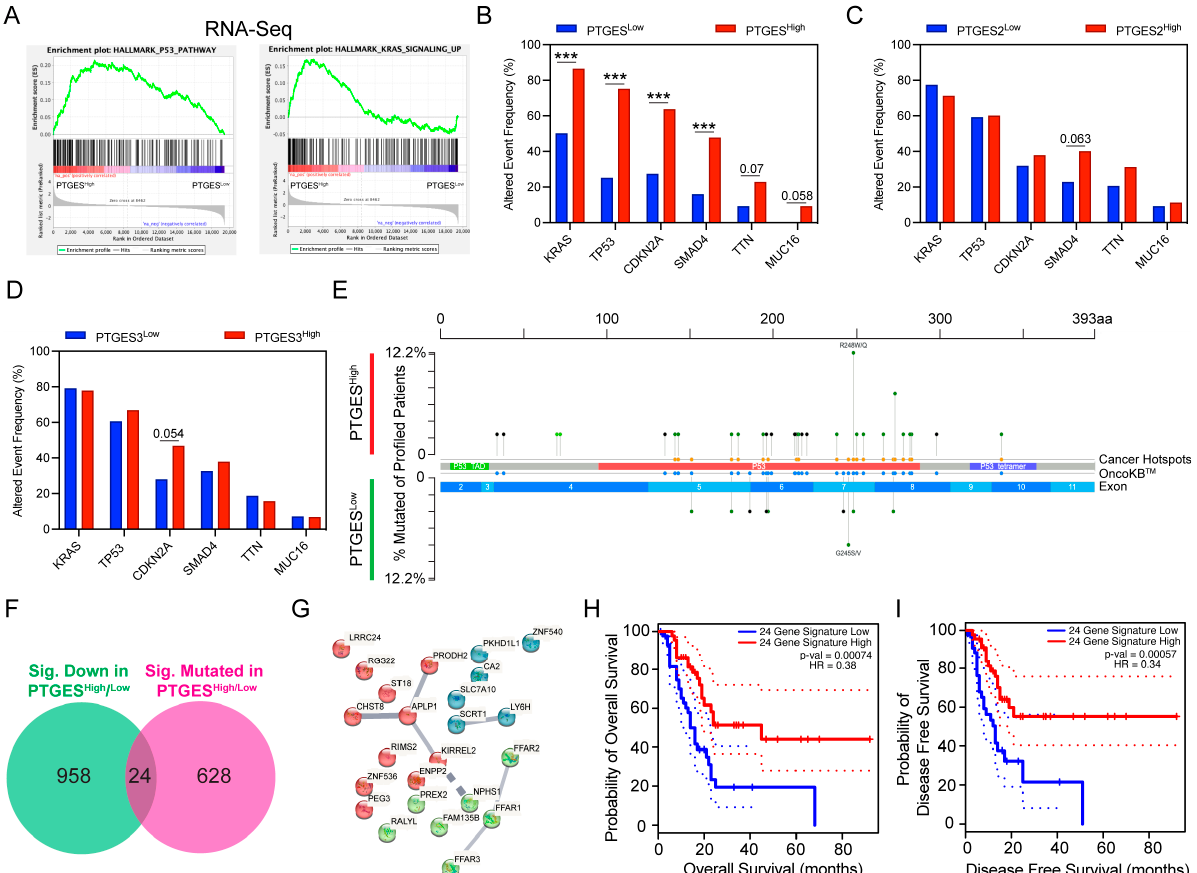
Figure 4. The mutational landscape of pancreatic cancer patients based on PTGES expression. ( A ) GSEA plots from the RNA-seq data based on GSEA expression showing positive enrichment of the P53 pathway and KRAS signaling pathway. ( B – D ) The mutational profiles of key driver genes (KRAS, TP53, CDKN2A, SMAD4, TTN, and MUC16) in pancreatic cancer between the patients with high and low expression of PTGES ( B ), PTGES2 ( C ), and PTGES3 ( D ) in pancreatic cancer patients from the TCGA cohort. ( E ) The mutational landscape of the P53 gene between the PTGES High and PTGES Low patient groups showing the location and higher incidences of mutations in the PTGES High group. Additional tracks show the cancer hotspot mutations. ( F ) Venn diagram shows 24 genes, the expression of which is impacted by the mutations. ( G ) The String gene network showing the subset of genes impacted by mutations. ( H ) The prognostic impact of the 24-gene signature on overall survival of pancreatic cancer patients stratified by quartile expression. ( I ) The prognostic impact of the 24-gene signature on disease-free survival of pancreatic cancer patients stratified by quartile expression. The p -values are denoted by *** < 0.001.